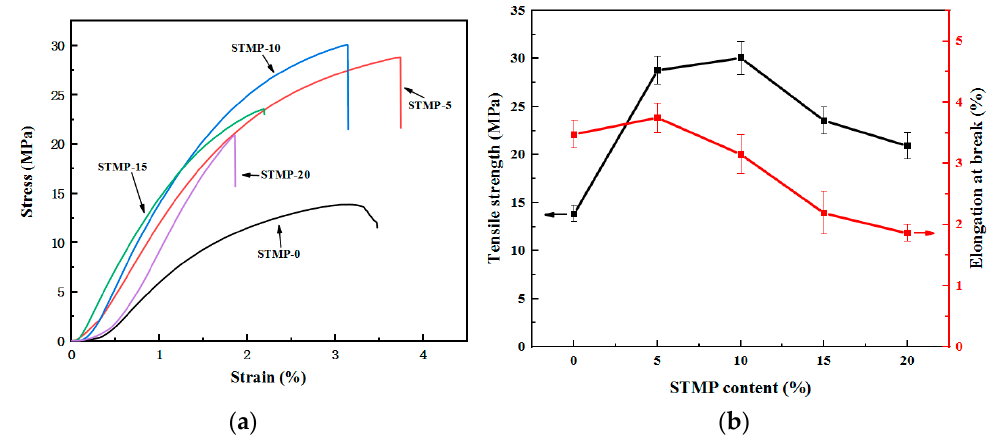
Figure 4. Mechanical properties of STMP crosslinked hemicellulose films ( a ) stress–strain curves;